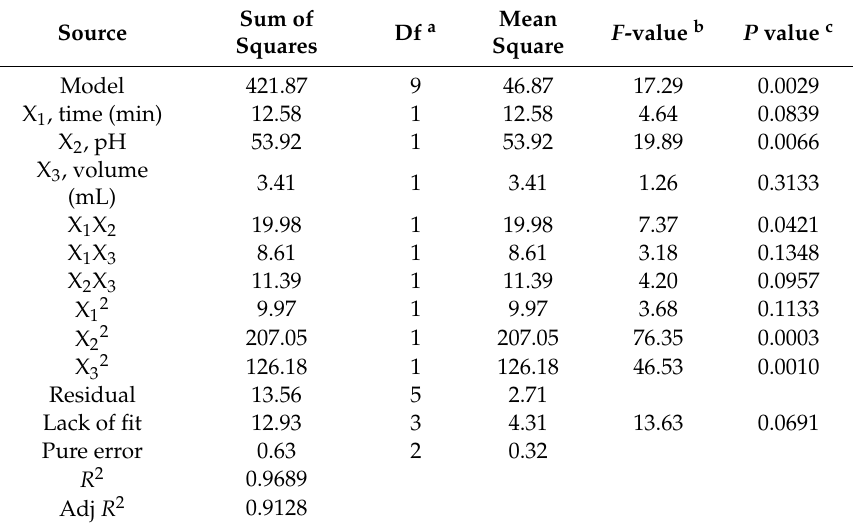
Table 3. Variance analysis of the response surface fitted model.